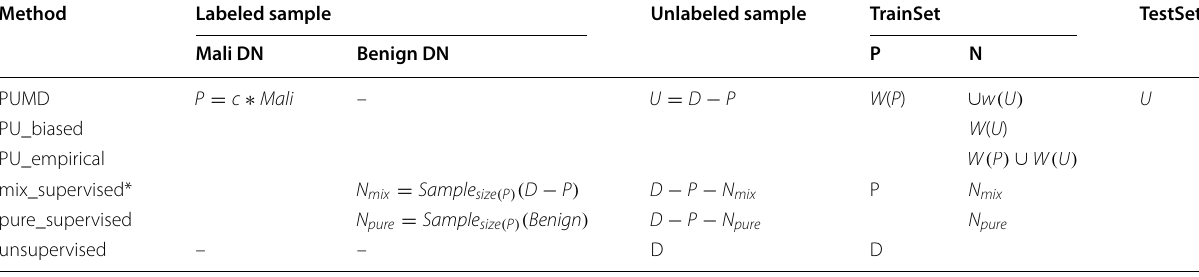
Table 12 Formal description of the data set